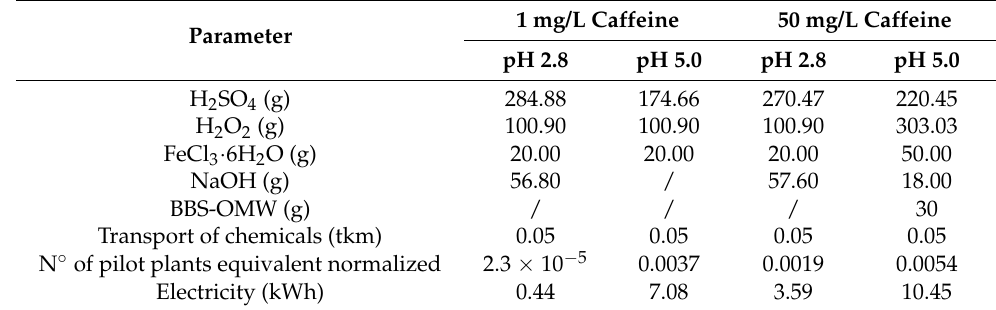
Table 6. Inventory data for the use phase: the treatment of 1 m 3 of contaminated water, with the 4 solar photo Fenton processes considered. Data are grouped for caffeine concentration and working